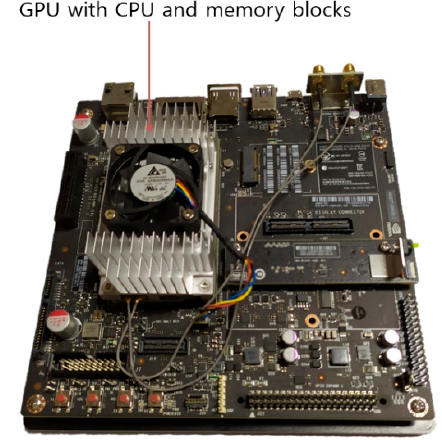
Table 16. Comparison of processing time on Jetson TX2 and desktop computer by VGG face net-16 and ResNet-50 (unit: ms).